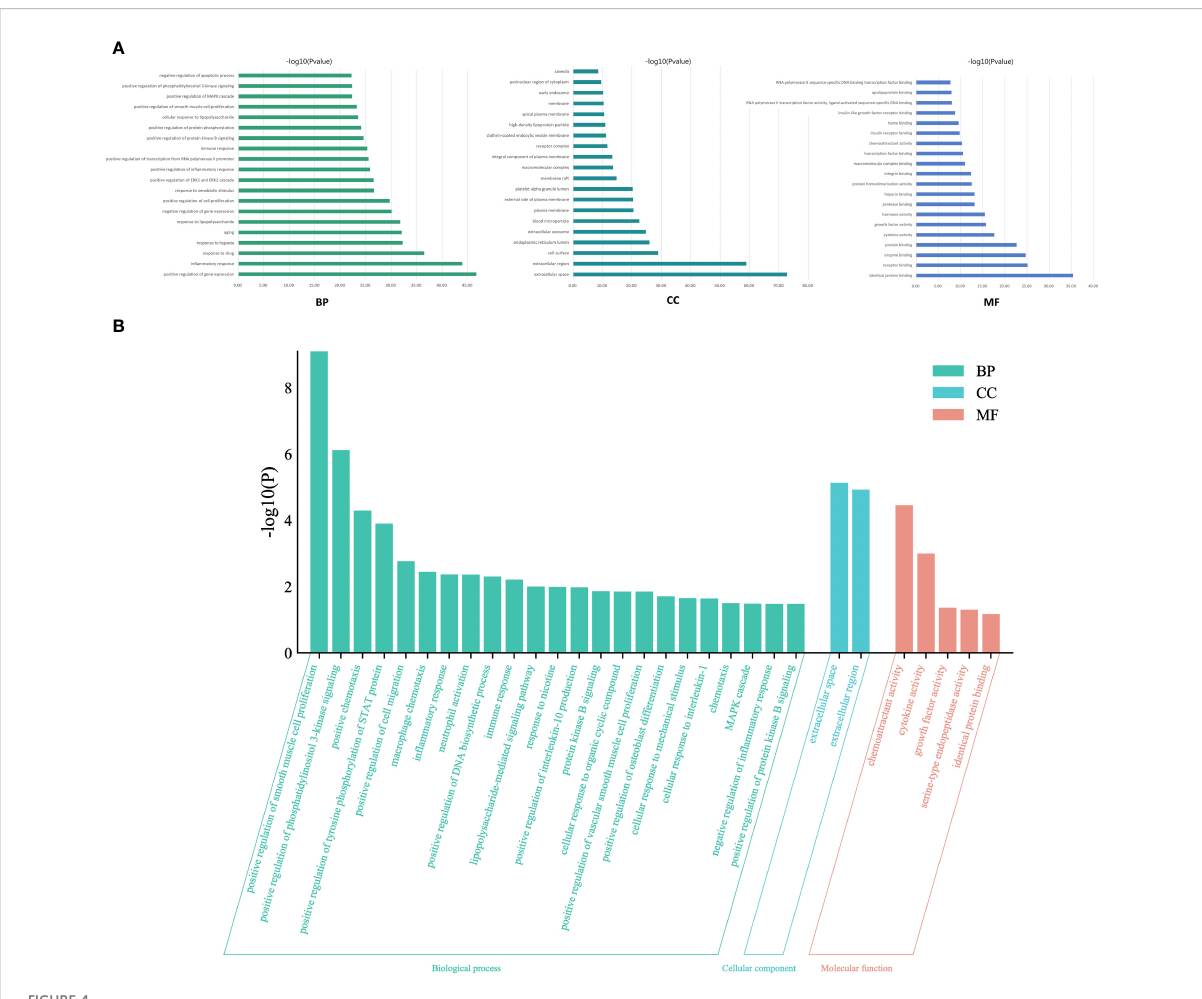
FIGURE 4 Gene Ontology enrichment analysis. (A) The most relevant biological process, cell component, and molecular function terms in all risk genes of DKD complicated with IBD. (B) The most relevant biological process, cell component, and molecular function terms in the key risk genes of DKD complicated with